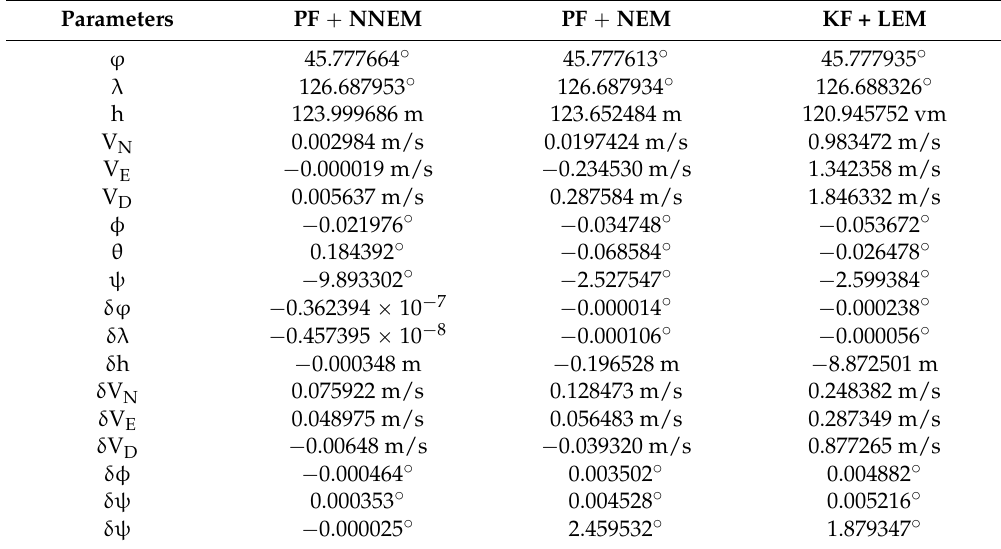
Table 3. Navigation solutions and corresponding errors estimated by PF with NNEM, PF with NEM, and KF with LEM in Experiment